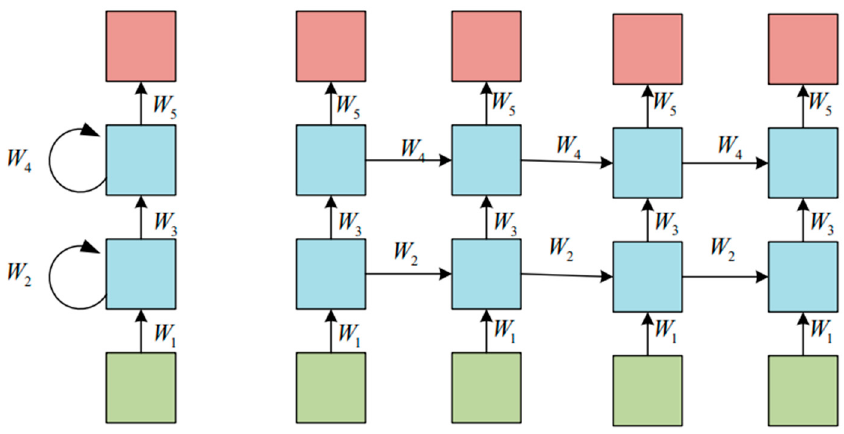
Figure 5. Structure of deep recurrent neural network.